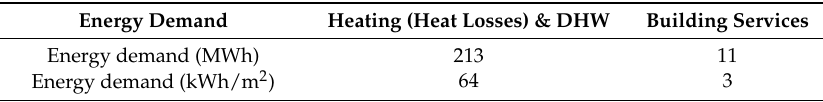
Table 2. Measured energy demand of the building.